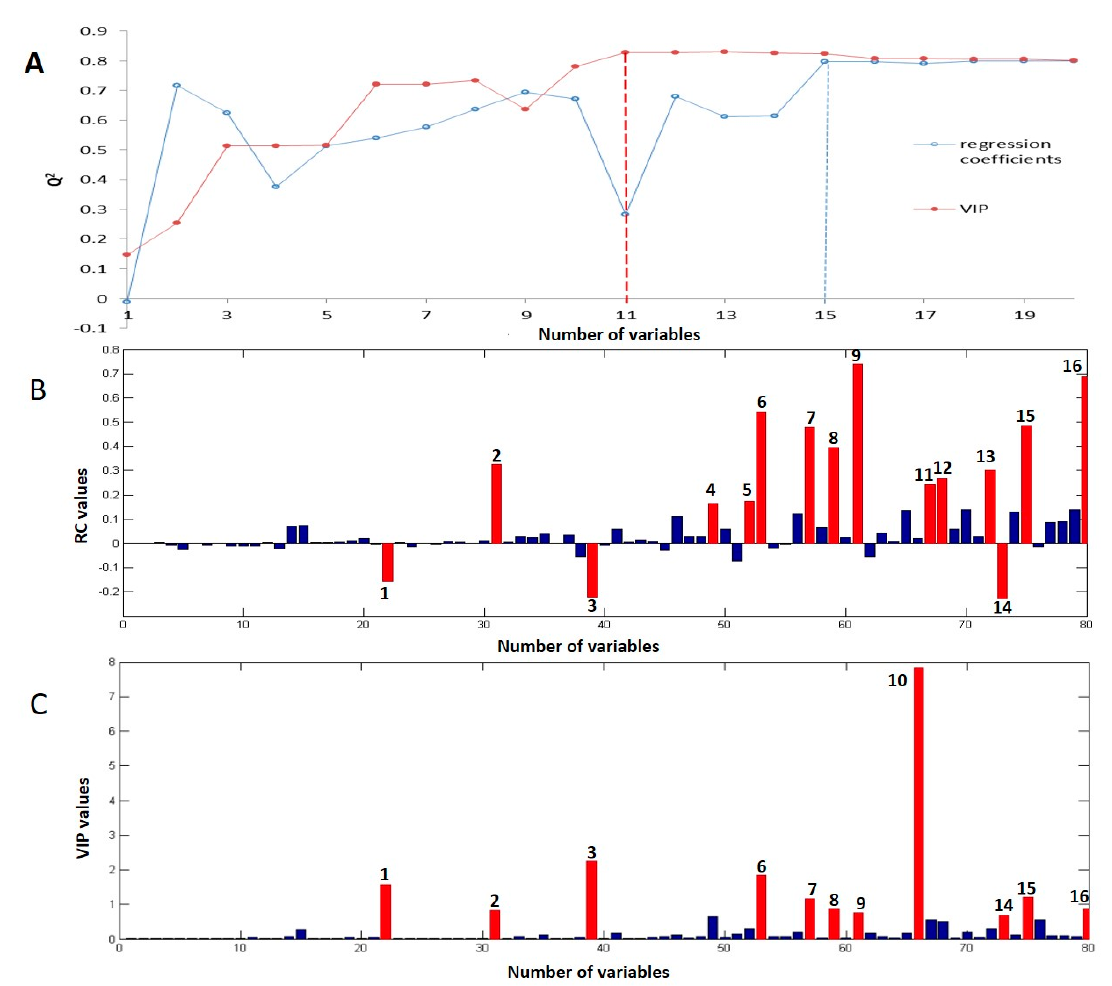
Figure 4. Screening of the key bioactive components: ( A ) The Q 2 of the partial least squares regression models of different combinations of variables. The first one was the variable with the highest variable importance in projection (VIP) or regression coefficient (RC) value. The second combination was the first one plus the second one, then the first three, and so on. In this study, the number of variables changed from one to twenty; ( B ) RCs of the PLS regression model (43 × 80) for the 80 components; ( C ) VIP value of each component. Fifteen and eleven components were selected by RC and VIP, respectively. There are ten common components selected by the two methods.